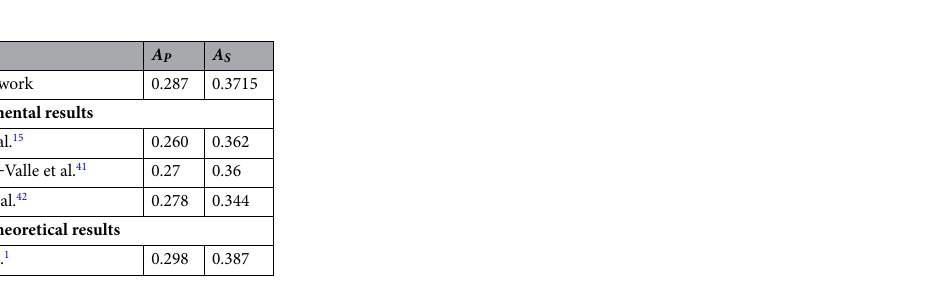
Table 3. Plane wave velocity anisotropy A P and shear wave velocity anisotropy A S of magnesite at 0